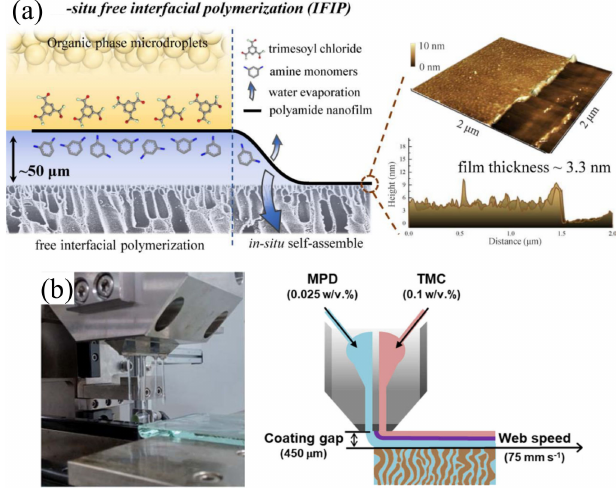
Figure 6. New IP technique for PA layer synthesis without having substrate. ( a ) Schematic diagram of in situ–free IP (IFIP) approach [63] and ( b ) dual-layer slot coating (DSC) apparatus and its schematic diagram